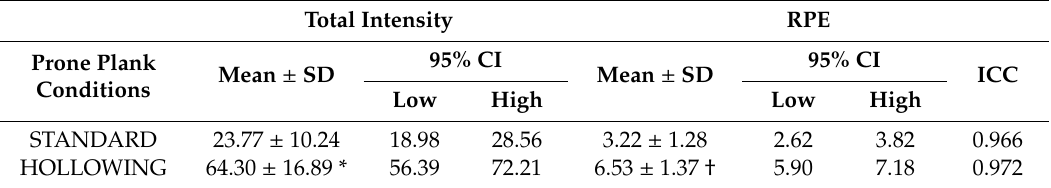
Table 3. Comparison of Total Intensity (%MVC) and RPE between prone plank